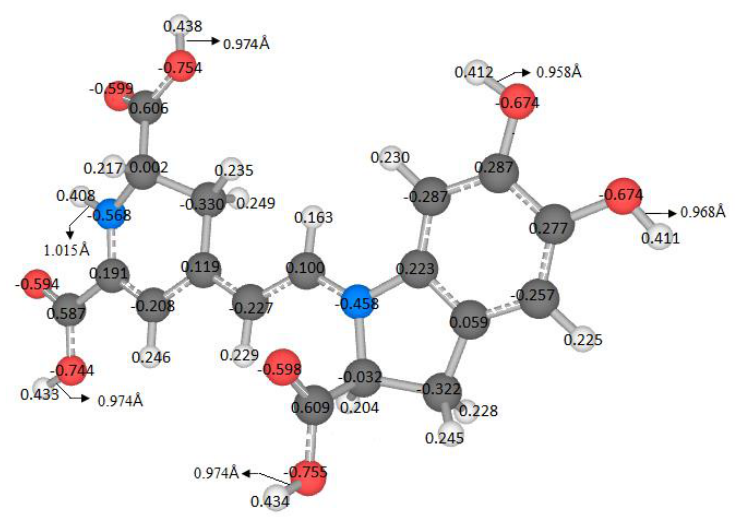
Figure 2. Partial charges in terms of the charge of the electron in C and bond lengths in Å .